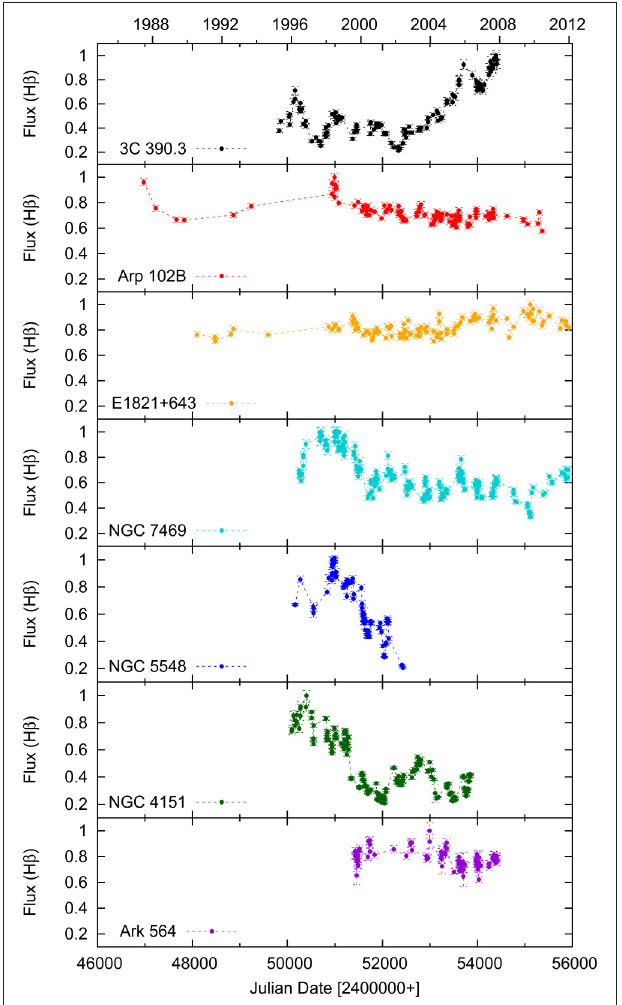
FIGURE 1 | Light curves of the H β line flux of all object in the sample (object name given in the bottom-left), normalized to the maximal flux for better comparison.